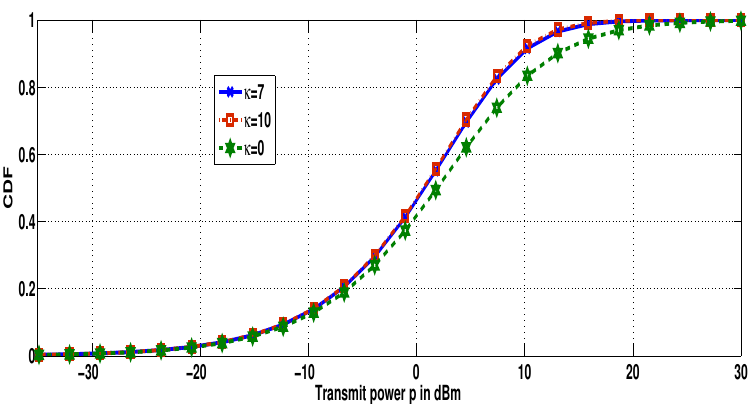
Figure 4. CDF of the transmit power for different values of κ